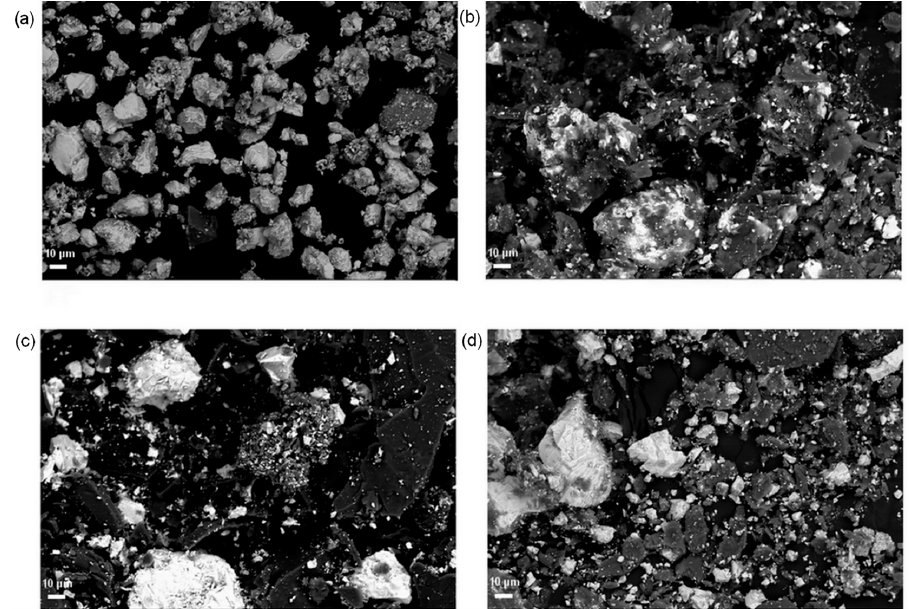
Figure 5. SEM back-scattered electron micrographs of: ( a ) historical cinnabar pigment of the Archae- ological Park of Pompeii, and powder mineral samples of ( b ) Almadén, ( c ) Entredicho, and ( d ) Las Cuevas obtained at the same magnification.